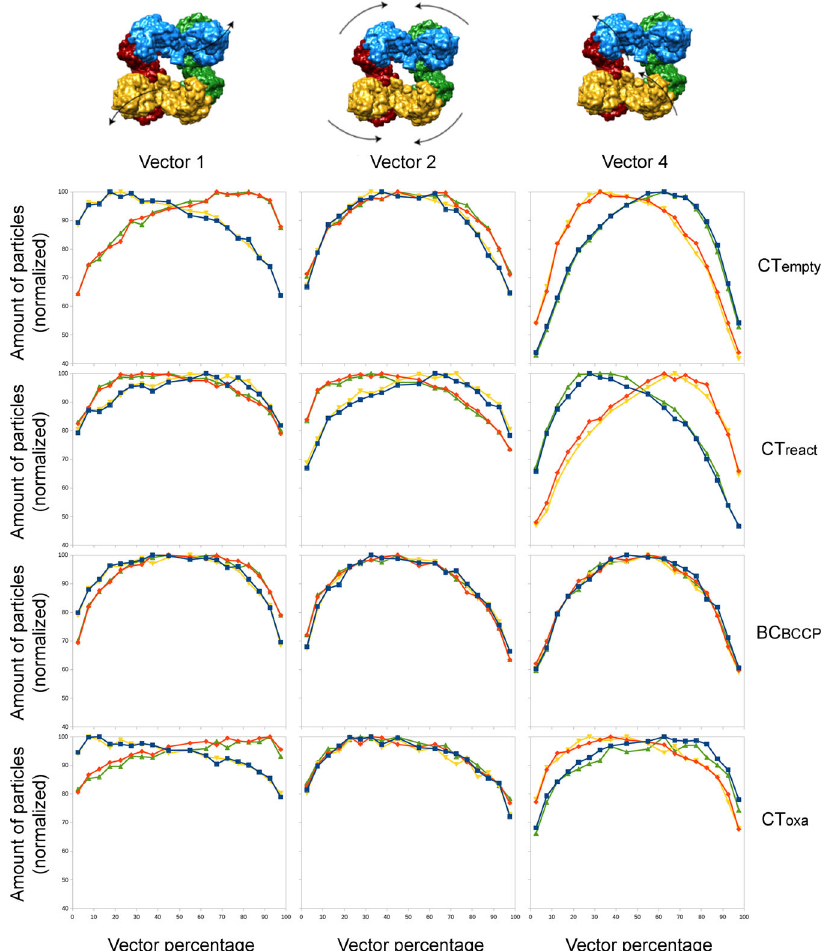
Fig. 8 | Analysis of the correlations between global motions and selected BC and CT classes. The columns show 3 main vectors of the multibody analysis and the rows show selected classes from BC and CT classi fi cation. Tetrameric models at the top display the different movements associated with the eigenvectors: